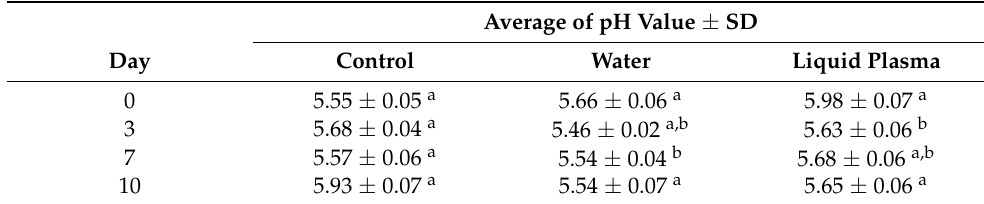
Table 6. Averages of the pH value of the inside of the pork samples ( n =